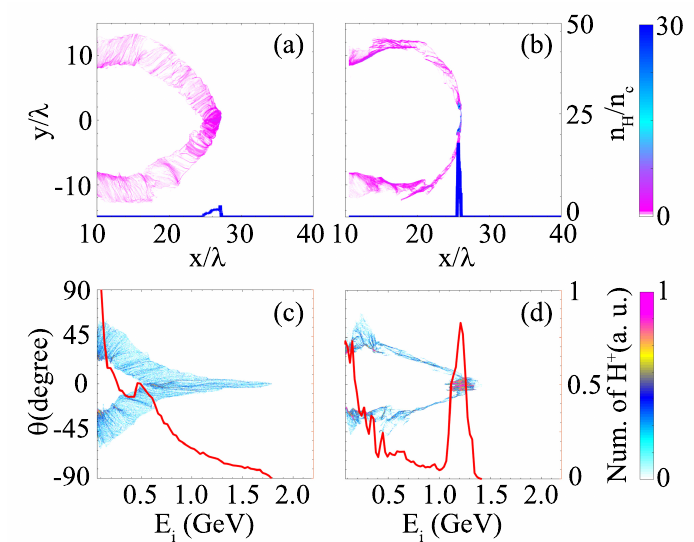
Figure 2. Comparison between different target configurations. ( a , b ) Proton distributions (color contour) and densities averaged at | y | ≤ 2 λ (blue line) at t = 40 T 0 obtained from the cases without and with the NCD plasma, respectively. In both cases, a CP laser pulse of a 0 = 100 and spot size R = 6 λ is employed. ( c , d ) The corresponding proton energy-angle ( θ = arctan ( p y / p x ) ) distributions (color contour) and energy spectra (red line).